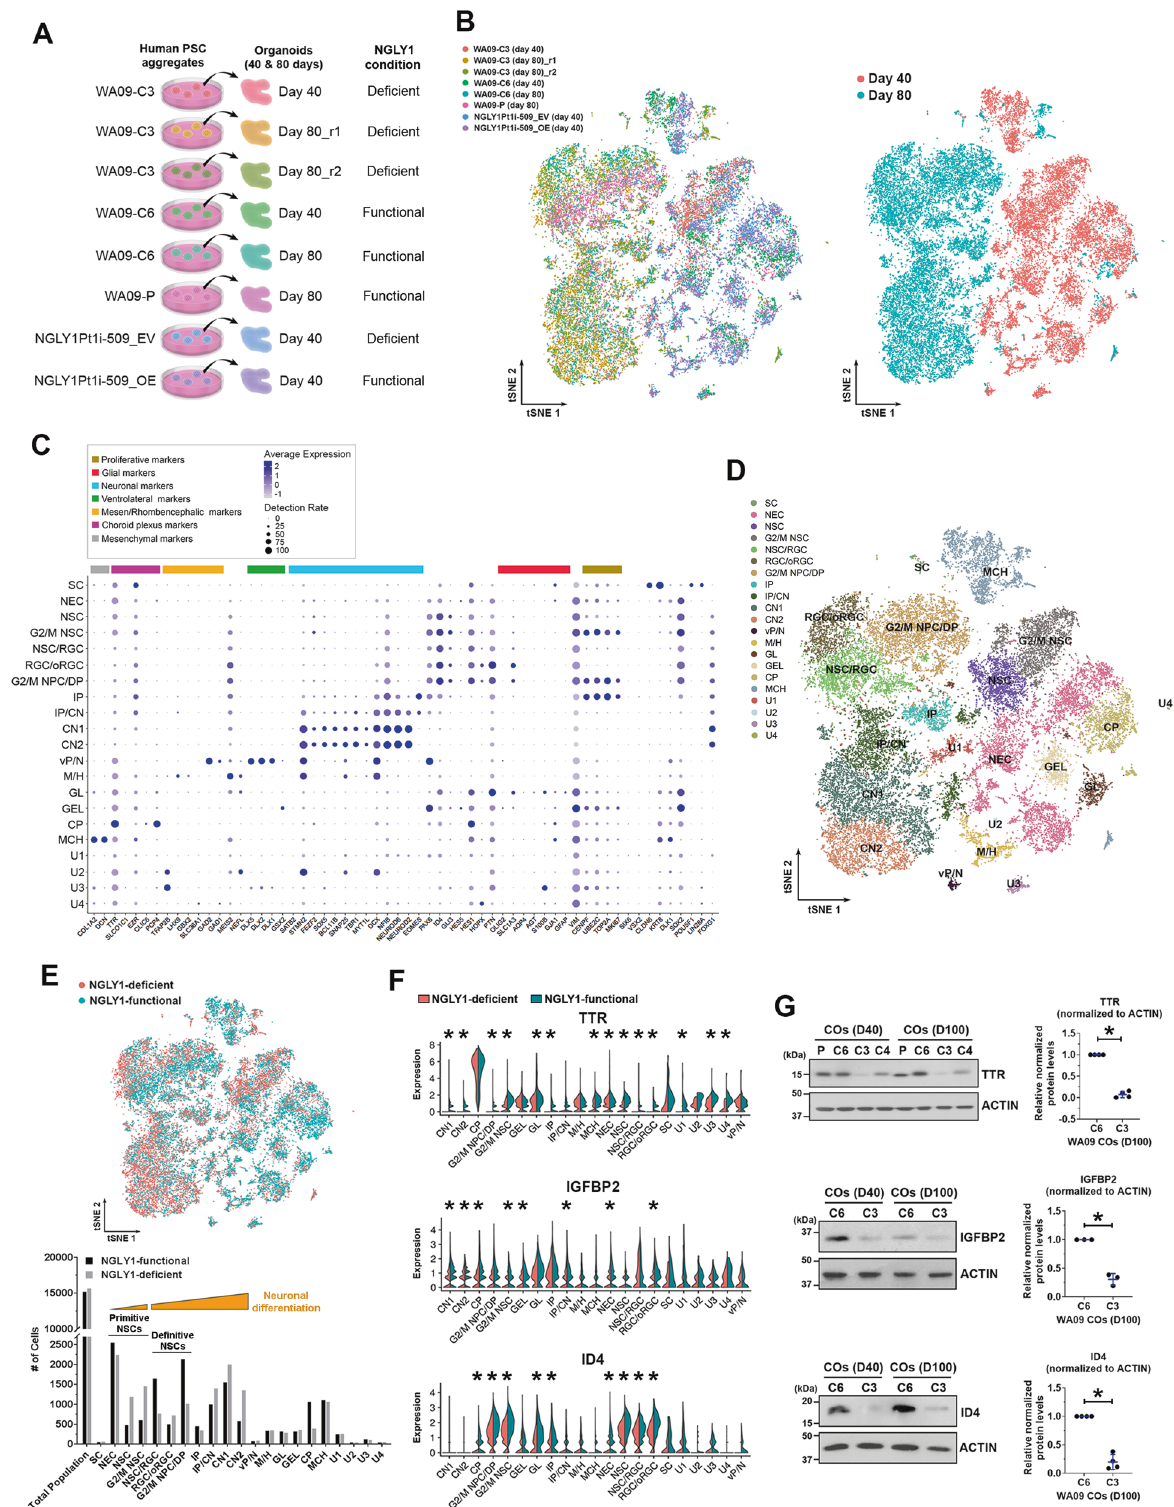
that the cellular components of day-40 and -80 COs are fundamentally different due to developmental progression. Based on the expression pro fi les of 60 marker genes (Fig. 5C), 14 neural cell types together with choroid plexus and mesenchymal cells in our COs were identi fi ed (Fig. 5D; Supplementary Fig. S6A,